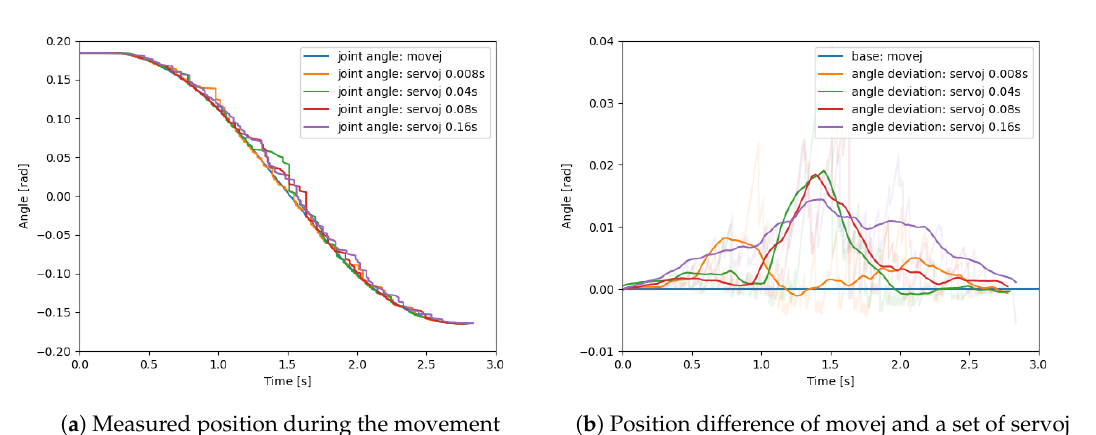
Figure 6. Position deviation of the 2nd joint (shoulder) between measurements with different movement prescription during the movement A (Figure 8a).